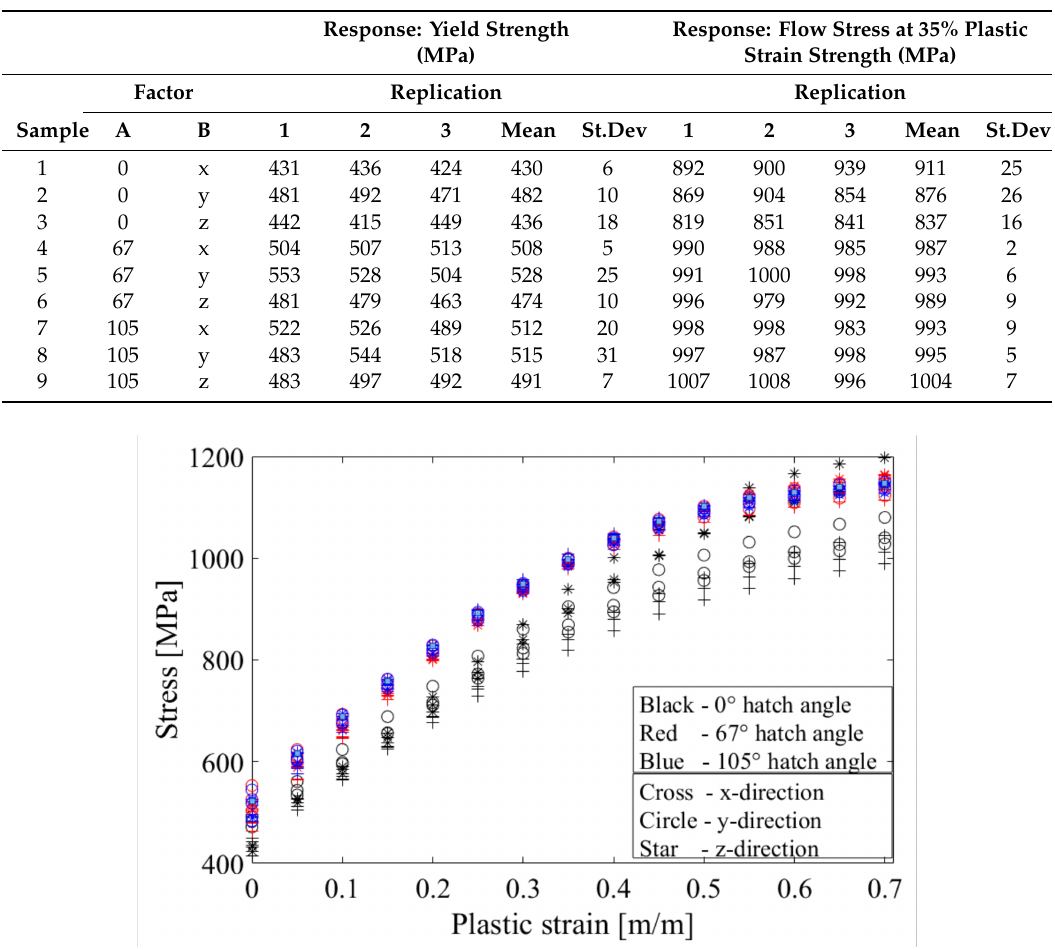
Figure 10. Plastic true stress–strain curve showing the compressive results for all tested